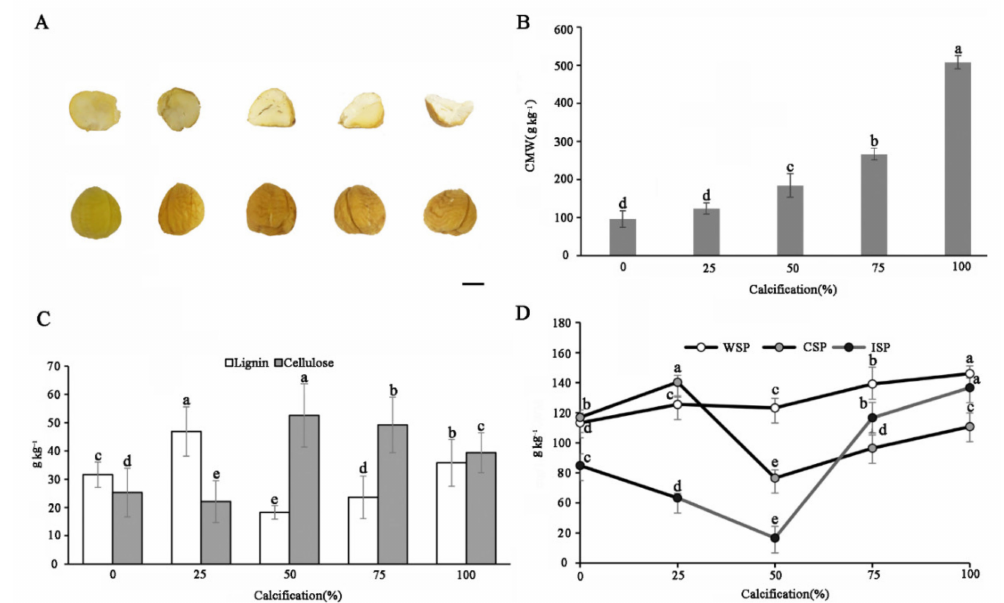
Figure 2. Changes in the cell wall content in different stages of chestnut calcification. ( A ) Degree of chestnut calcification, from left to right, 0%, 25%, 50%, 75%, and 100%. Scale bars, 1 cm. ( B ) Changes in cell wall material (CWM) in different stages of chestnut calcification. ( C ) Changes in lignin and cellulose contents in different stages of chestnut calcification. ( D ) Changes in the pectin content at different stages of chestnut calcification. All of the data were expressed as means ± standard deviations. Different letters (a–e) in the same composition indicate significant difference ( p < 0.05, Duncan’s multiple range